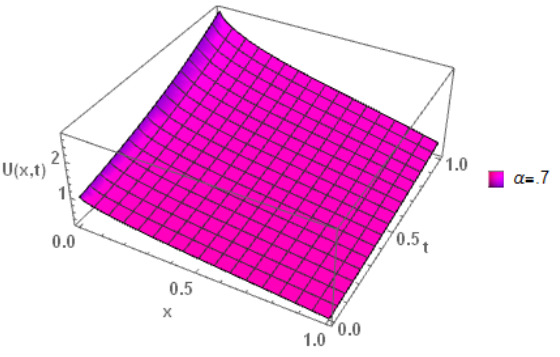
Fig. 5: Behavior of second term approximate solution U ( x , t ) w.r.t. x and t, when α = 0.7 for Eqs. (7)–(8).